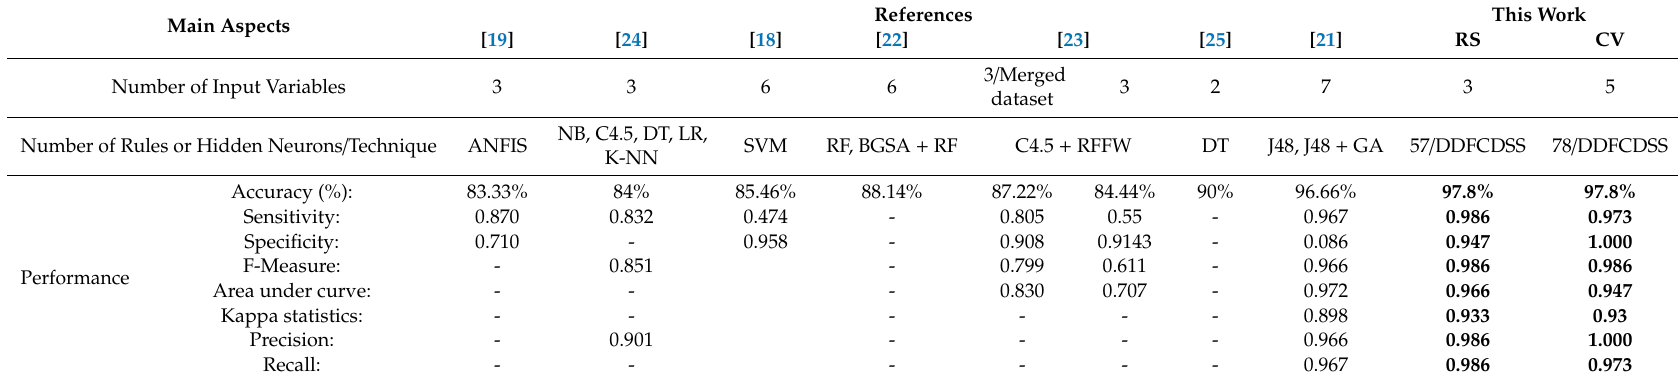
Table 12. Performance metrics obtained with our proposed framework and other classifiers obtained from the literature for wart treatment (Immunotherapy)